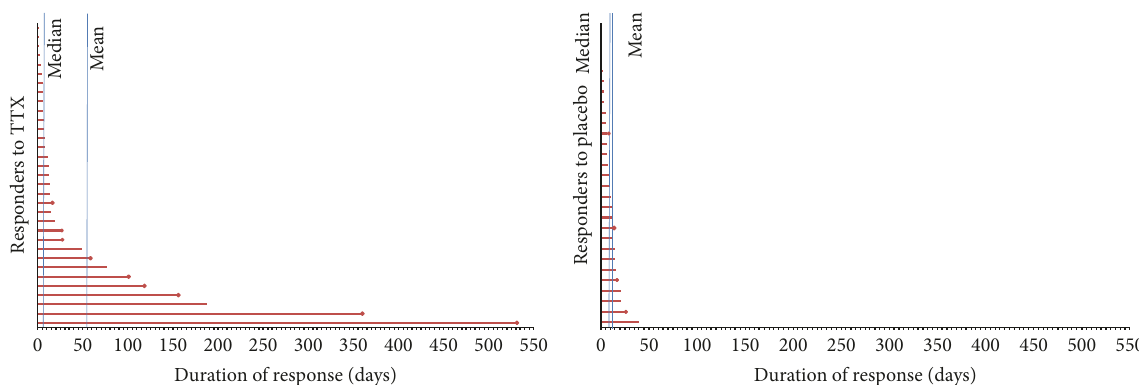
Figure 1: TTX for cancer pain: secondary analyses. Response duration (TTX responders versus placebo responders).